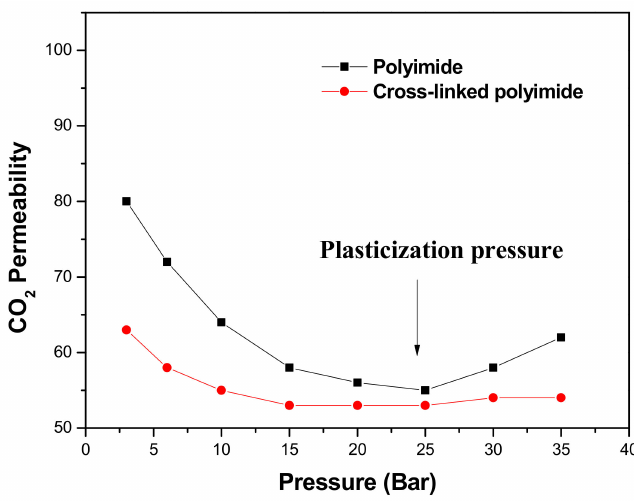
Figure 1. Plasticization process in a linear and a crosslinked polyimide